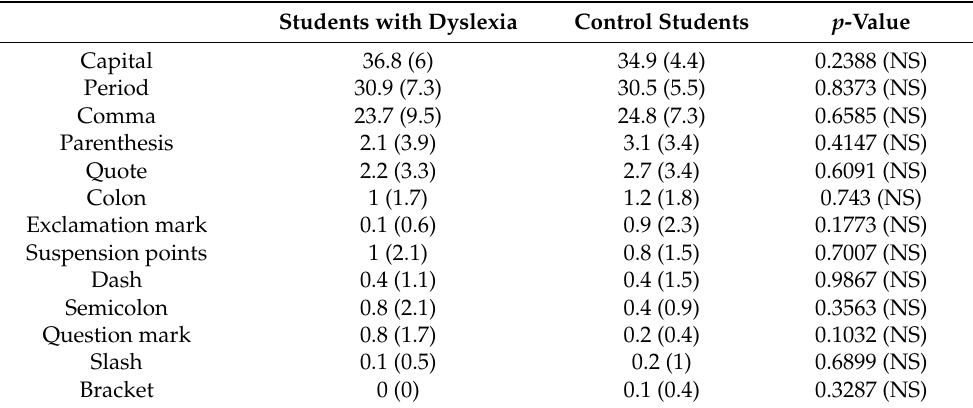
Table 5. Proportion of marks in a given punctuation category (mean, SD, and Welch p -value: NS = non significant/S =